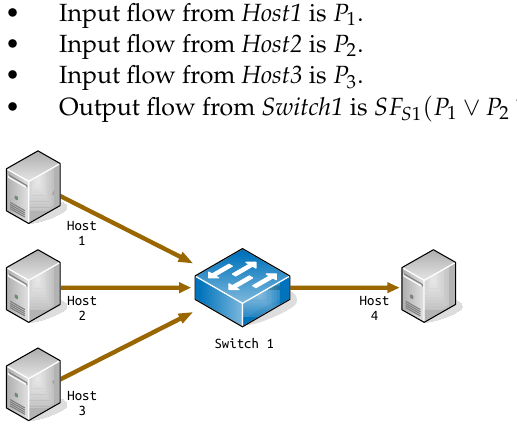
Figure 4. An example network ( S NET ) with single switch